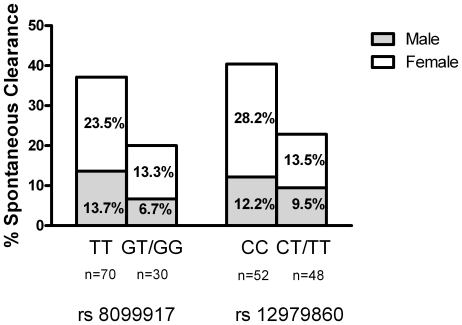
Distribution of sex for each genotype plotted by spontaneous HCV clearance rate.Genotyping was available for 100/106 participants. Bars represent the total percentage of spontaneous HCV clearance for the protective alleles (TT for rs8099917 and CC for rs12979860) and non-protective alleles (CT/GG for rs8099917 and CT/TT for rs12979860). The numbers in the bars indicate the percentage of spontaneous HCV clearance for males and females for each allele.